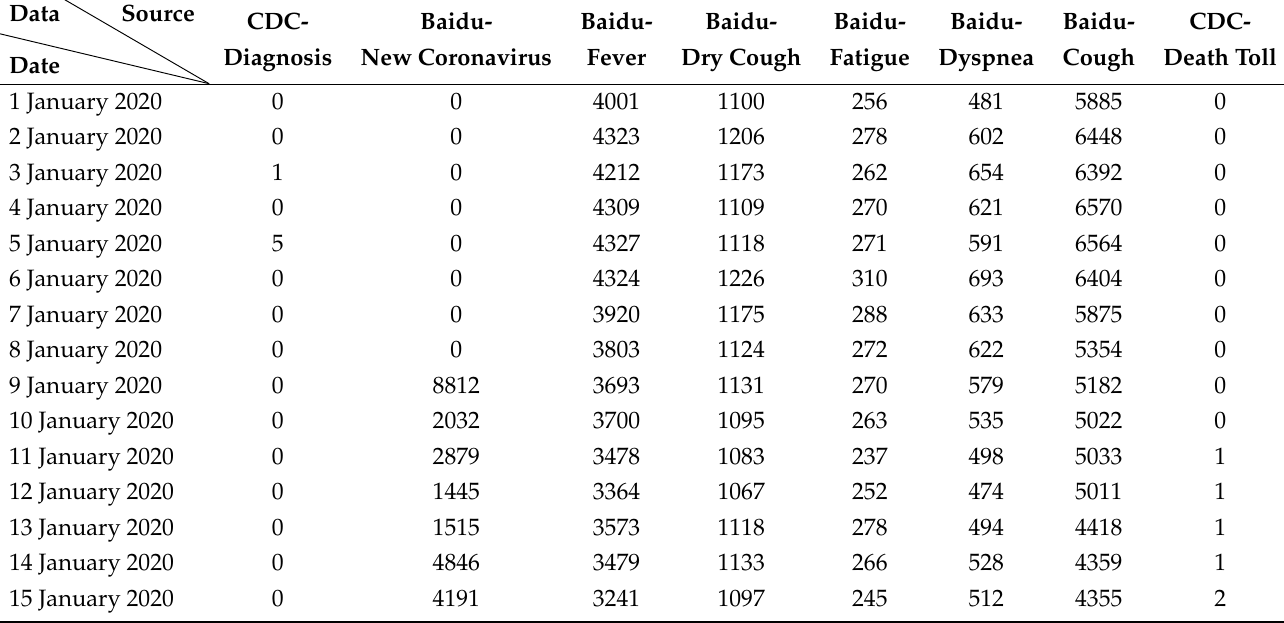
Table 1. Partial data from CDC and Baidu Index